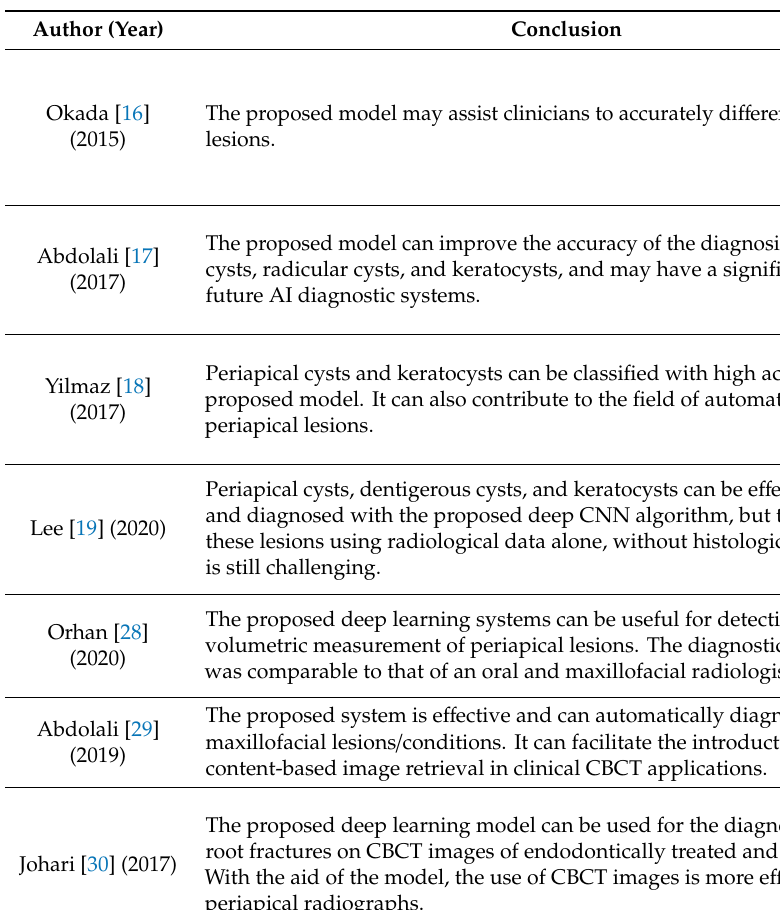
Table 3. Conclusions and limitations of the included